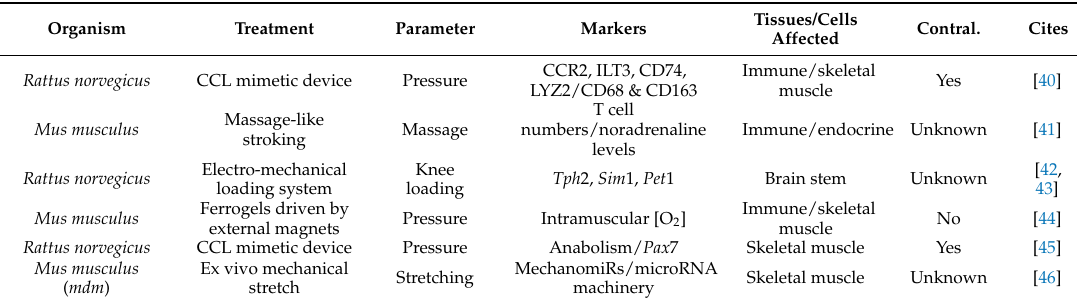
Summary of studies showing relevant preclinical data for initial MPTA (molecular physiotherapy approach) MT-based